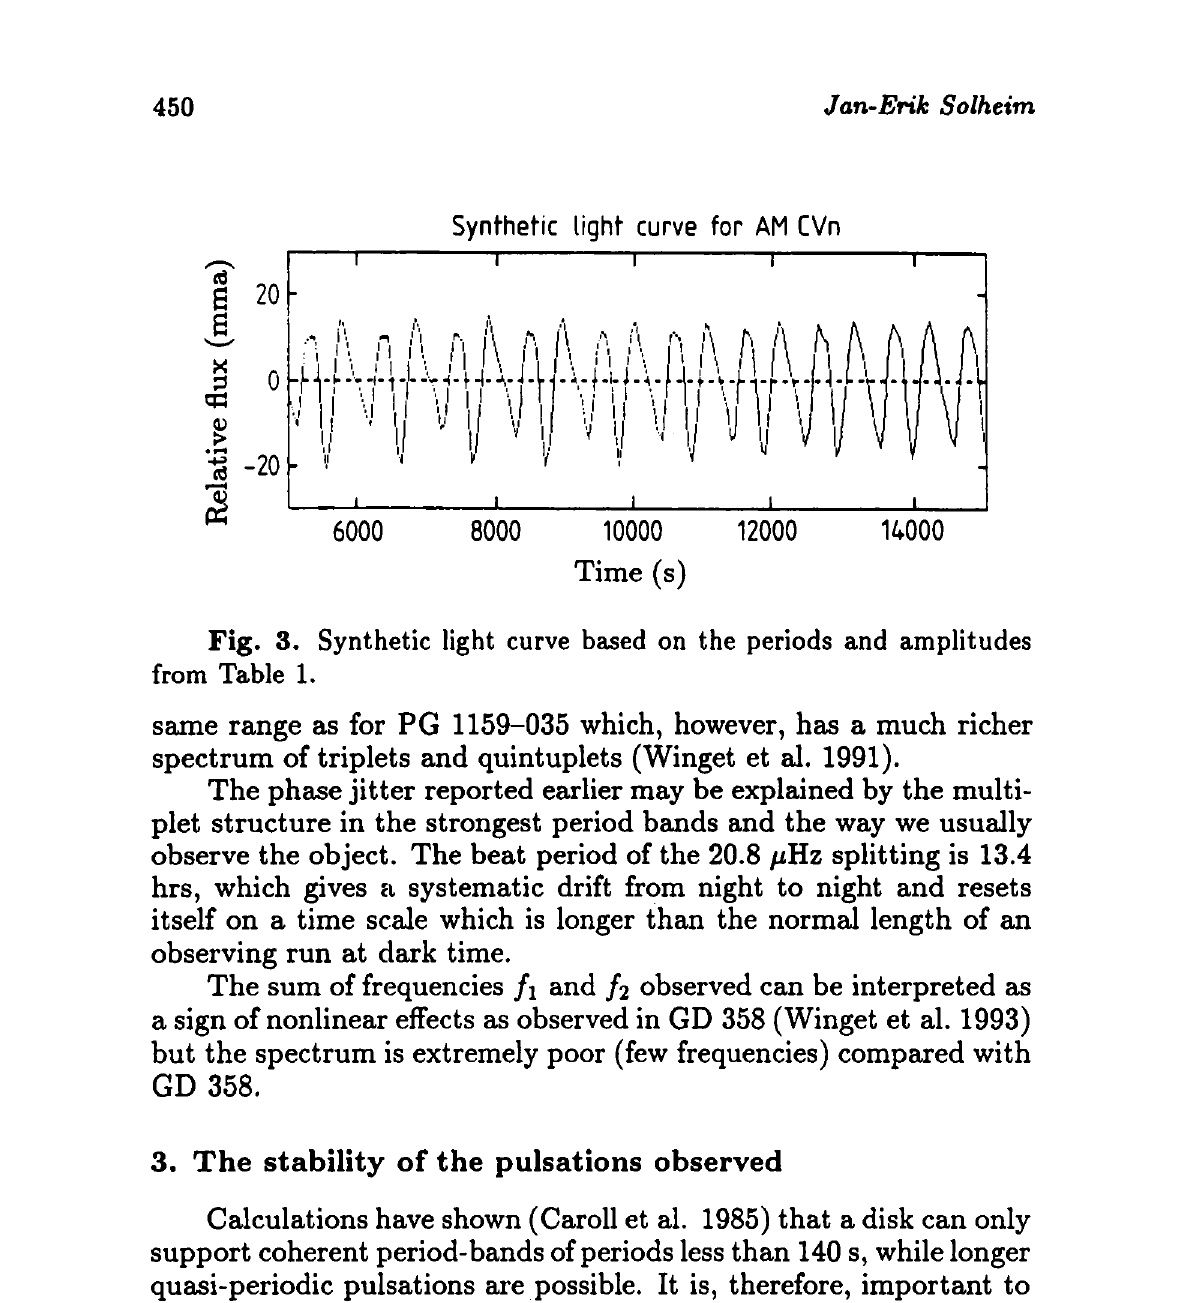
Fig. 3. Synthetic light curve based on the periods and amplitudes from Table